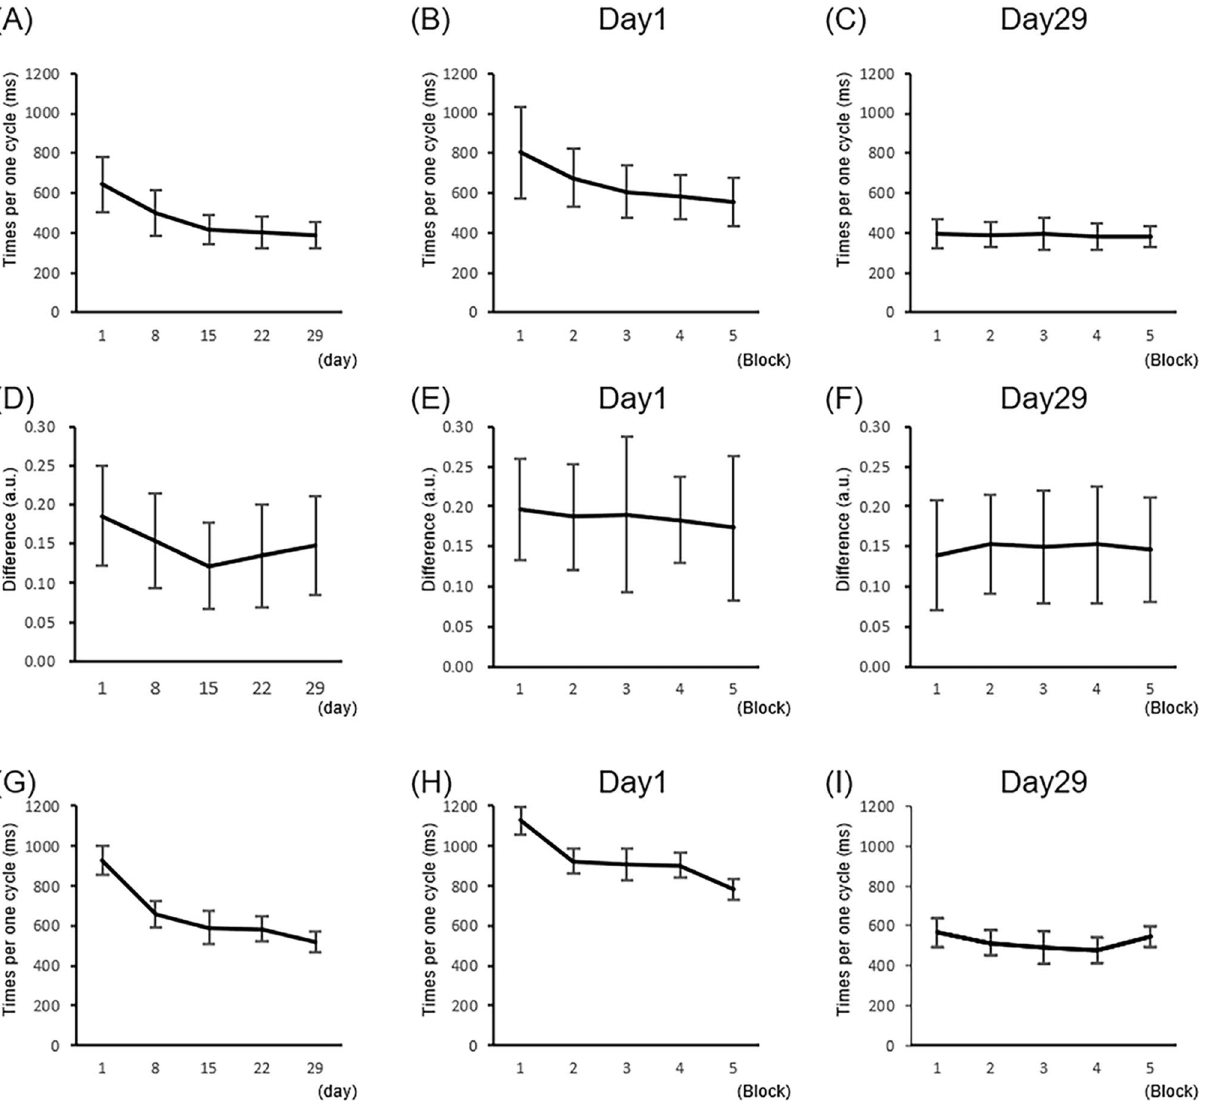
Figure 2. ( A ) Time spent for one cycle in the ball-rotation task across measurement days (day 1 vs. day 8: p = 5.8 × 10 –4 , d = 1.16; day 8 vs. day 15: p = 0.002, d = 0.84). ( B ) Time spent for one cycle in the ball-rotation task on day 1. Significant improvement was observed in only one block practice (block 1 vs. block 2: p = 0.0017, d = 0.67). ( C ) Time spent for one cycle in the ball-rotation task on day 29. Significant improvement was not observed (p > 0.0125). ( D ) Difference in digit coordination pattern between the ball-rotation and the reproduction tasks across measurement days. The difference significantly decreased from day 1 to day 8 ( p = 0.009, d = 0.52). ( E ) Difference in digit coordination pattern between the ball-rotation and the reproduction tasks on day 1. The difference did not change within day 1 ( p > 0.0125). ( F ) Difference in digit coordination pattern between the ball-rotation and the reproduction tasks on day 29. The difference did not change within day 29 ( p > 0.0125). ( G ) Time spent for one cycle in the reproduction task across measurement days (day 1 vs. day 8: p = 5.5 × 10 –4 , d = 1.47). ( H ) Time spent for one cycle of the reproduction task on day 1. Significant improvement was observed within day (block 1 vs. block 5: p = 0.0016, d = 1.32). ( I ) Time spent for one cycle in the reproduction task on day 29. Significant improvement was not observed ( p > 0.0125). Error bars indicate 1 standard